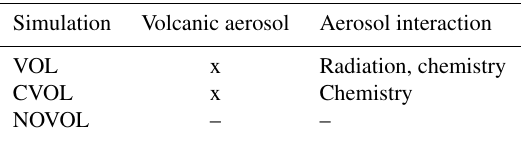
Table 1. Overview of the three simulations with their differences in model set-up.